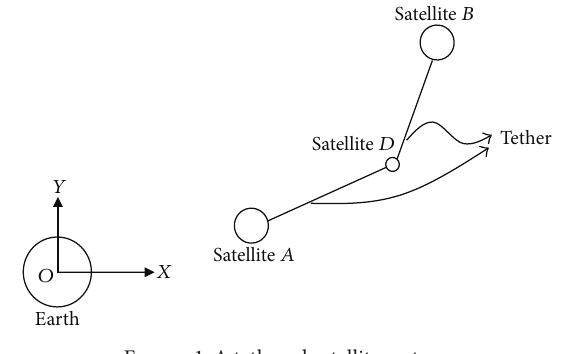
Figure 1: A tethered satellite